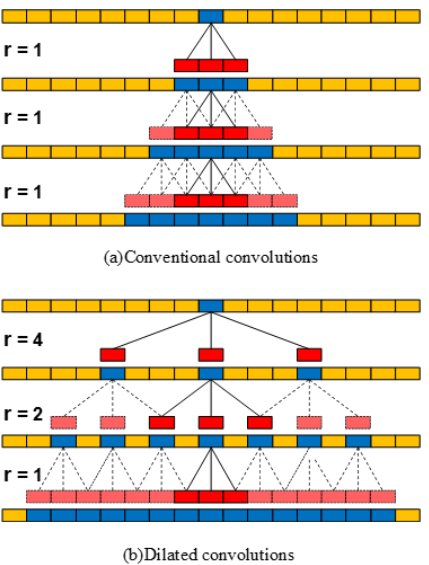
Figure 1. Conventional convolution and dilated